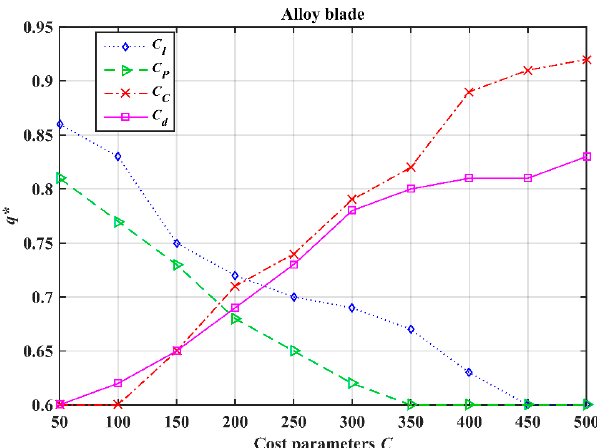
Figure 14. Influence of the cost parameters on the optimal value 𝑞 ∗ .